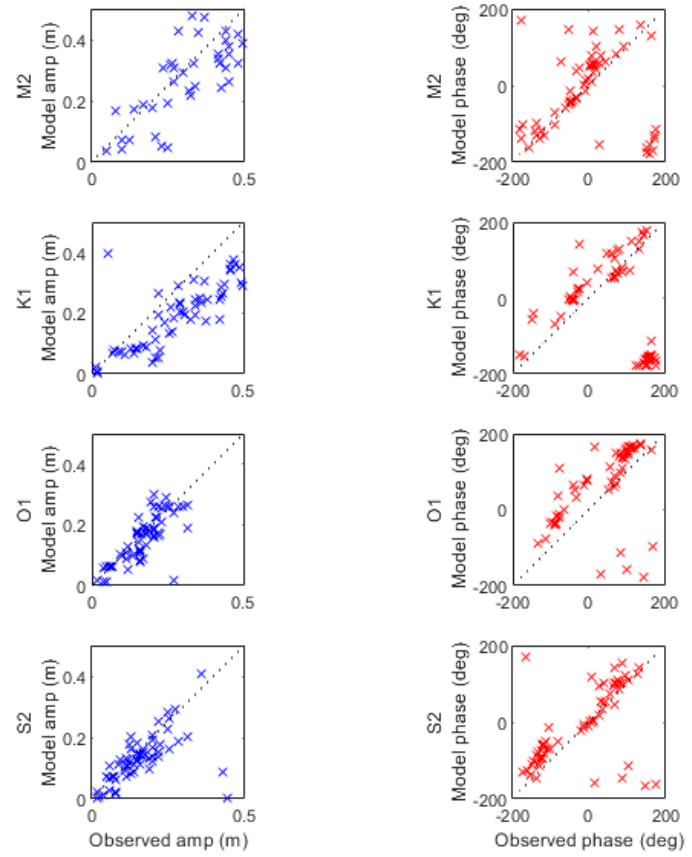
Figure 8. Comparison of tidal amplitude and phase for tidal constituents M2, K1, O1 and S2.